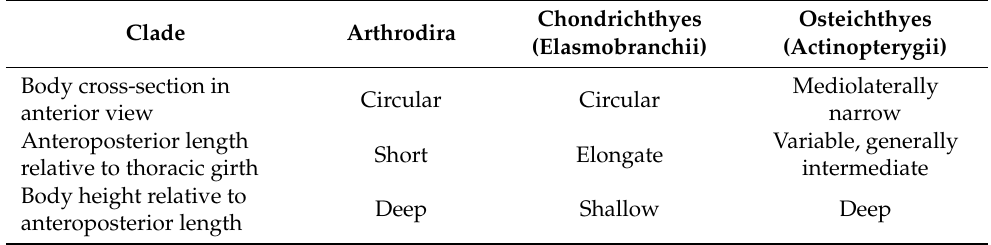
Table 6. Broad-scale differences in body proportions between the three major fish clades considered in this study. Note Chondrichthyes here almost exclusively refers to Elasmobranchii as extant holocephalians and batoids have heavily modified body plans (though extinct chondrichthyans like Cladoselache are generally similar in body shape to extant elasmobranchs), and Osteichthyes almost exclusively refers to actinopterygians due to low availability of data for